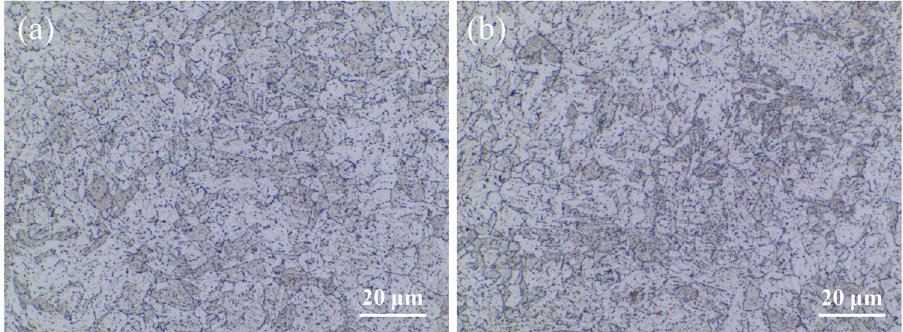
Figure 2: Optical microscope images showing microstructures of the 2.25Cr1Mo0.25V steel: ( a ) BM and ( b )